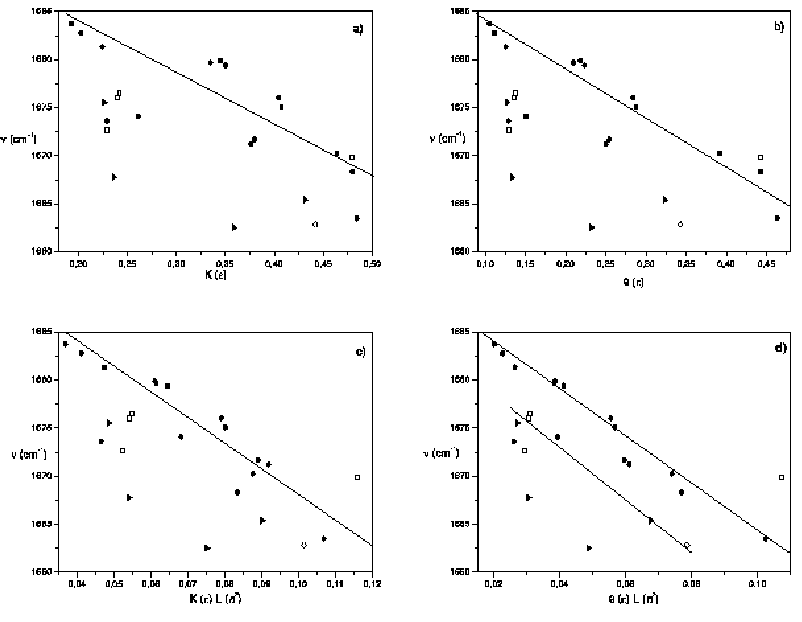
Figure 3. Dependence of the Frequency of the C=O stretching band for acetylferrocene as a solute in aprotic solvents with specific reaction field functions: (a) Kirkwood-Bauer function